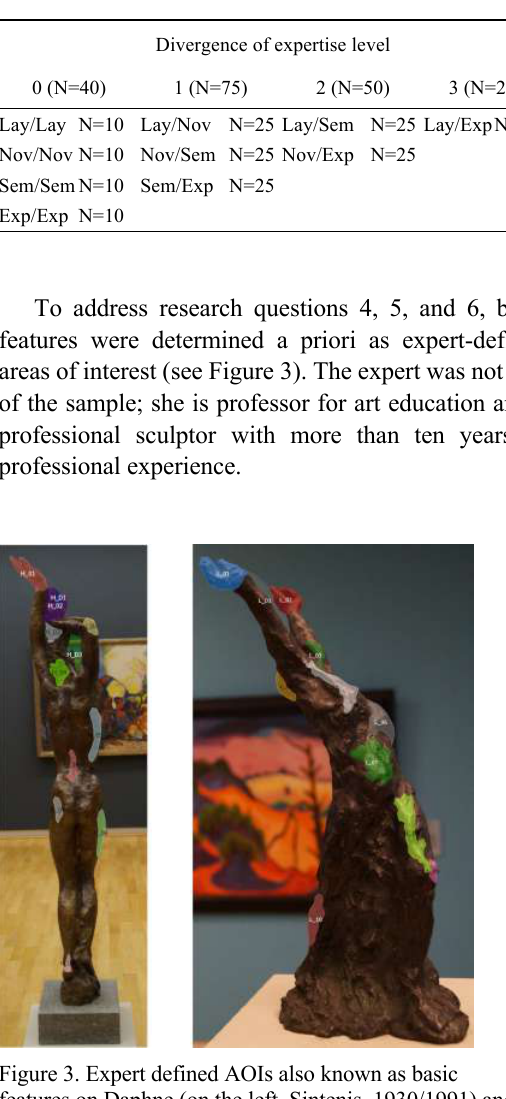
Table 2. Allocation of the distances into four groups with divergent expertise levels.